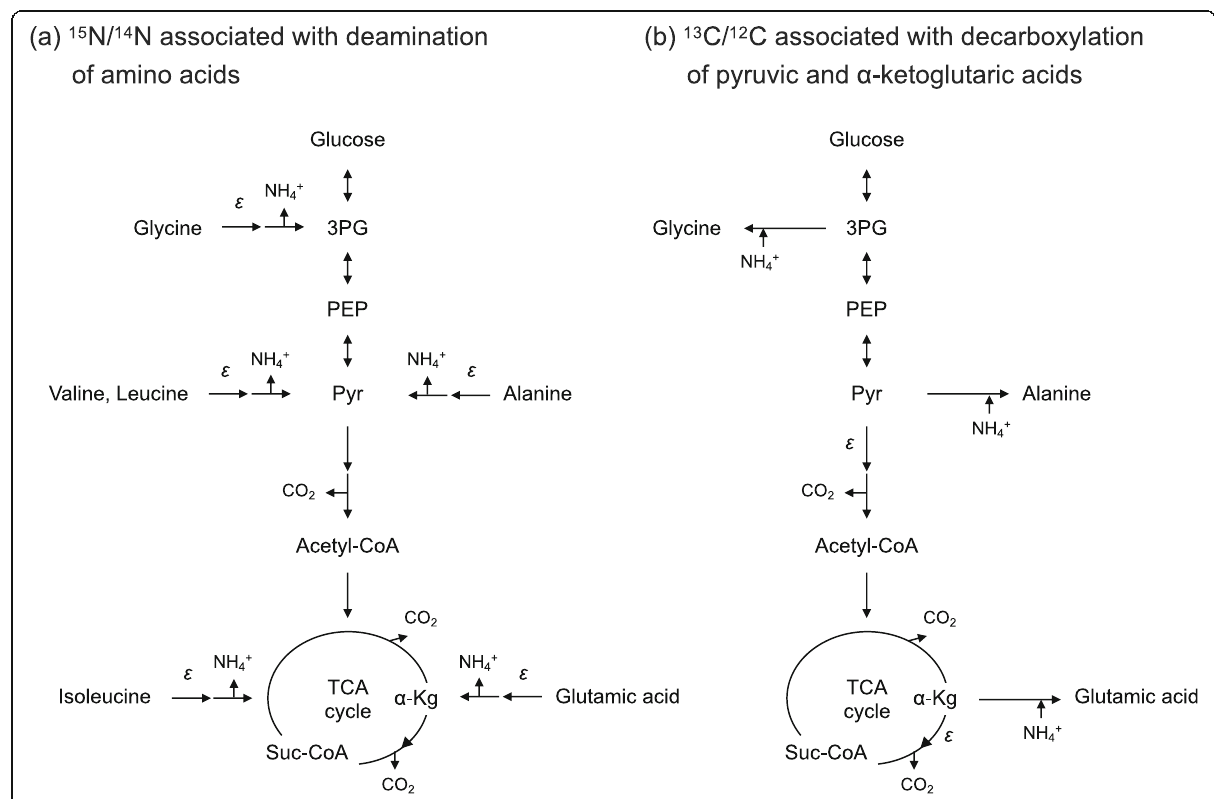
Fig. 3 Simplified metabolic map of degradation and synthetic networks of the amino acids (i.e., glycine, alanine, valine, leucine, isoleucine, glutamic acid, and phenylalanine) with respect to isotopic fractionation: a 15 N/ 14 N associated with deamination of amino acids and b 13 C/ 12 C associated with decarboxylation of pyruvic acid (Pyr) and α -ketoglutaric acid ( α -Kg). 15 N can be enriched in the six amino acids (i.e., glycine, alanine, valine, leucine, isoleucine, and glutamic acid), and 13 C can be enriched in the three amino acids (i.e., glycine, alanine, and glutamic acid) and their precursors on the